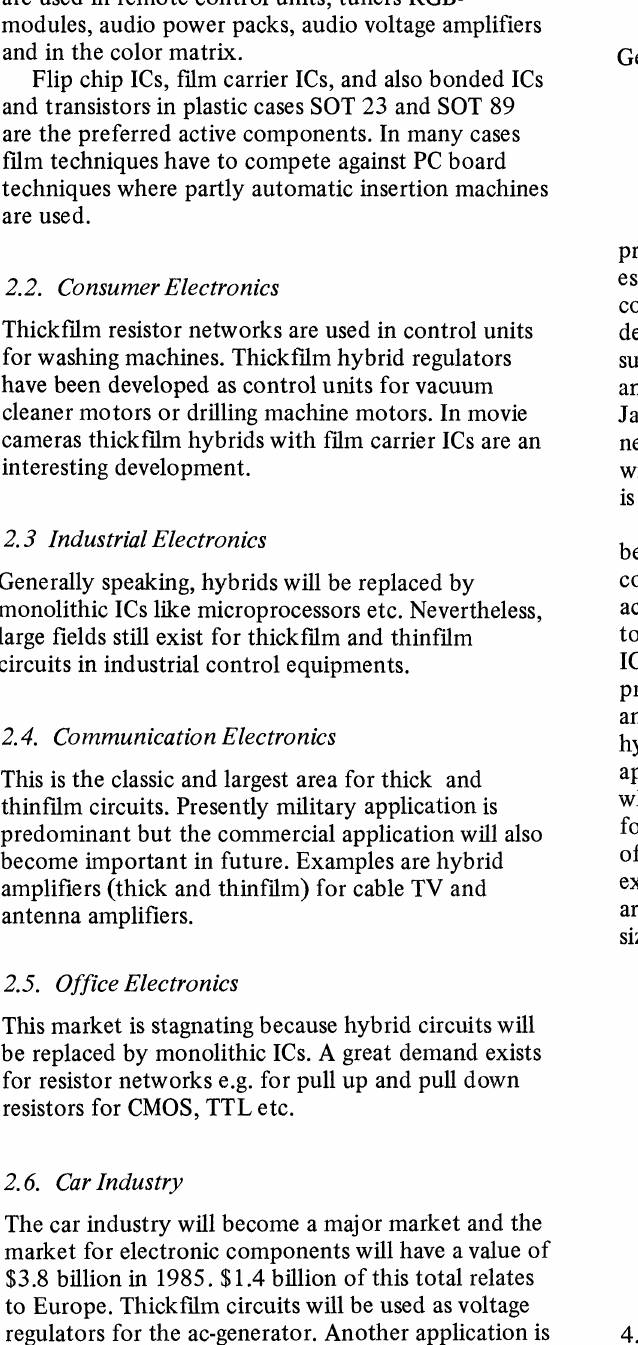
Cost per resistor element of a standard network consisting of 7